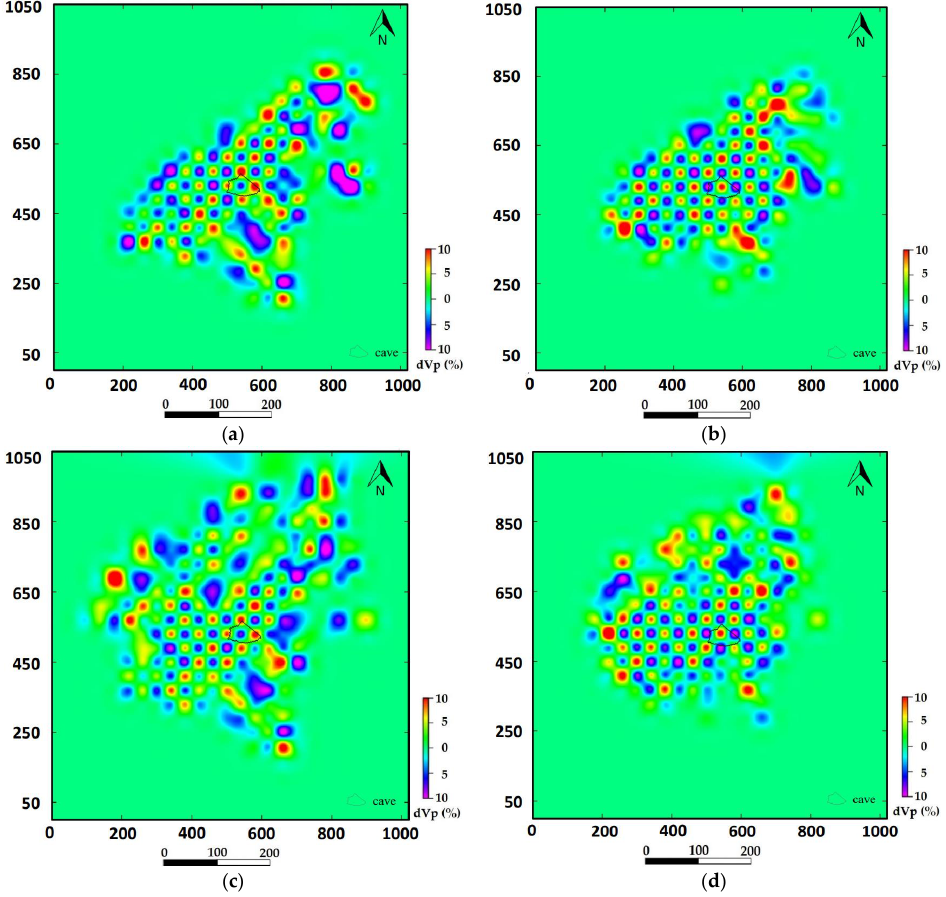
Figure 11. Vp tomogram in the seismogenic zone: ( a ) elevation 1820 msl seismometer scenario following the facility; ( b ) elevation 1820 msl seismometer scenario in the off-facilities area; ( c ) elevation 1780 msl seismometer scenario following the facility; ( d ) elevation 1780 msl seismometer scenario in the off-facilities